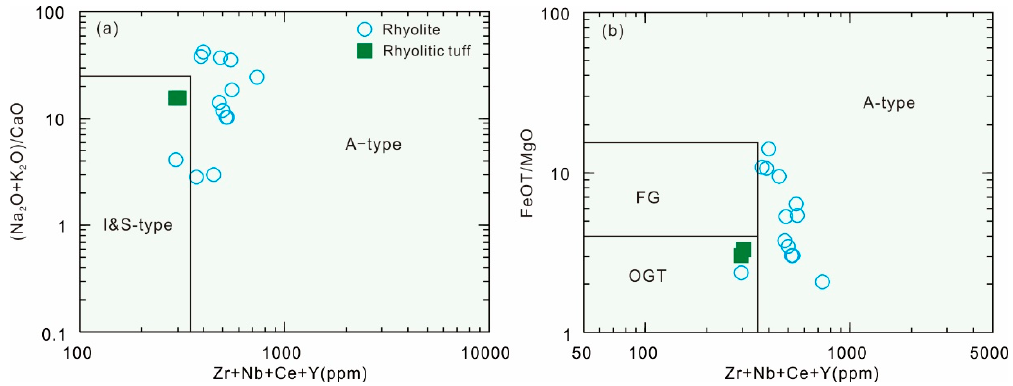
Figure 8. Plot of (Na 2 O + K 2 O)/CaO versus Zr + Nb + Ce + Y, FeOT/MgO versus Zr + Nb + Ce + Y discrimination diagrams for the Early Devonian volcanic rocks from Haerdaban area in the northern margin of Yili Block ( a , b , reference area after [58]).